Question: Judging by this figure, is the value going up or going down?
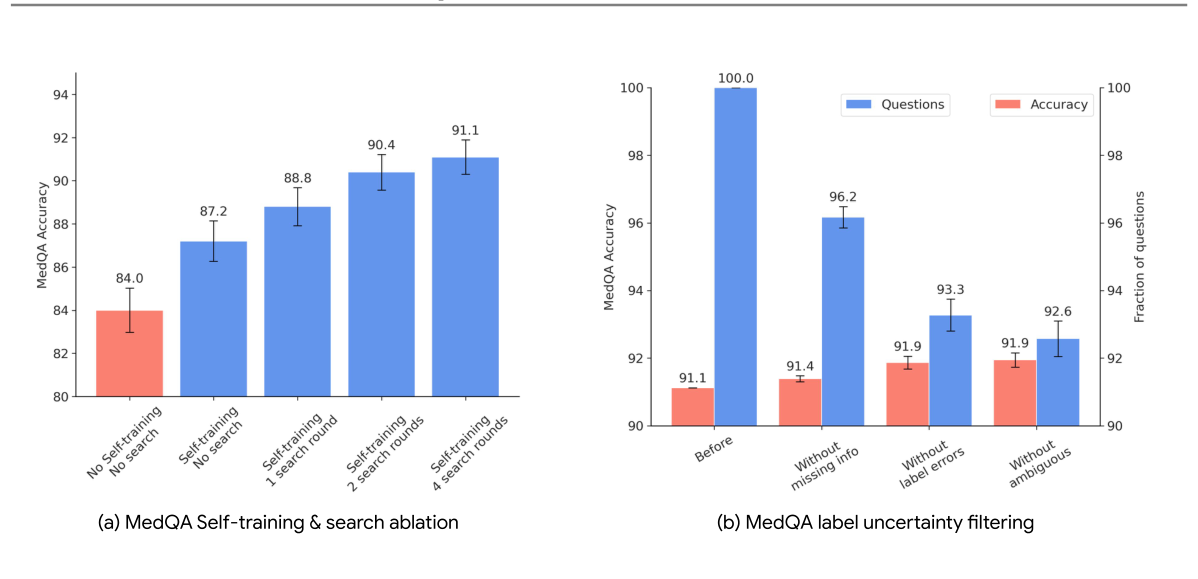
Answer: increasing